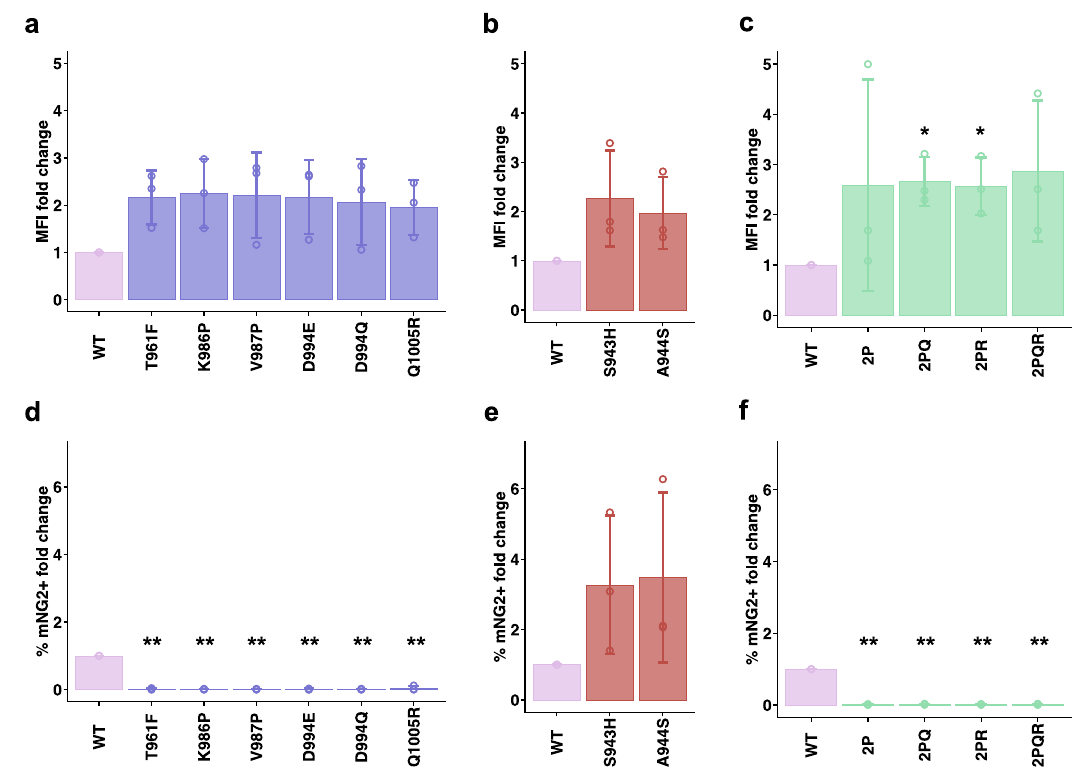
Fig. 3 | Validation of candidate prefusion-stabilizing mutations.a – c Expression of prefusion-stabilizing mutations ( a ), fusion-enhancing mutations ( b ), and com- binations of candidate prefusion-stabilizing mutations of S ( c ) relative to WT. Of note, the numerical values of fold change in median fl uorescence intensity (MFI) indicate relative and not absolute fold changes in surface expression levels of S. d – f Fold changein fusion activity of candidate prefusion-stabilizing mutations ( d ), fusion-enhancing mutations ( e ), and combinations of candidate prefusion-